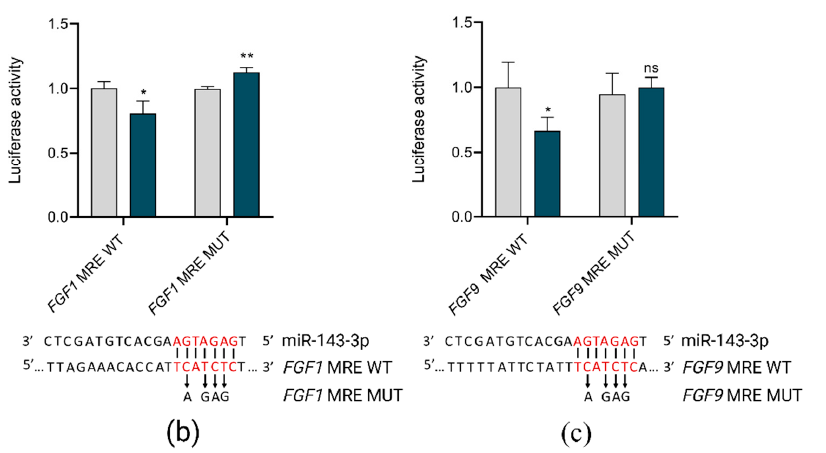
Figure 4. In vitro validation of direct interactions of miR-143-3p with FGF1 , FGF9 and KRAS . pCDH EV, pCDH empty vector; pCDH miR-143-3p, pCDH vector containing miR-143-3p coding sequence MRE, miRNA responsive element in 3 ′ UTR of target gene; WT, wild-type sequence; MUT, sequence with mutations introduced within MRE; *** p < 0.001; ** p < 0.01; * p < 0.05; ns, not significant. The graphs present the decrease in relative luciferase activity in the presence of miR-143-3p in reference to control (empty vector). For each graph, the predicted interaction sites of miR-143-3p with MREs are shown, with indication of nucleotides mutated in the rescue experiment. ( a ) Interactions between miR-143-3p and two MREs in KRAS gene. ( b ) Interaction between miR-143-3p and MREs in FGF1 gene. ( c ) Interaction between miR-143-3p and MREs in FGF9 gene.